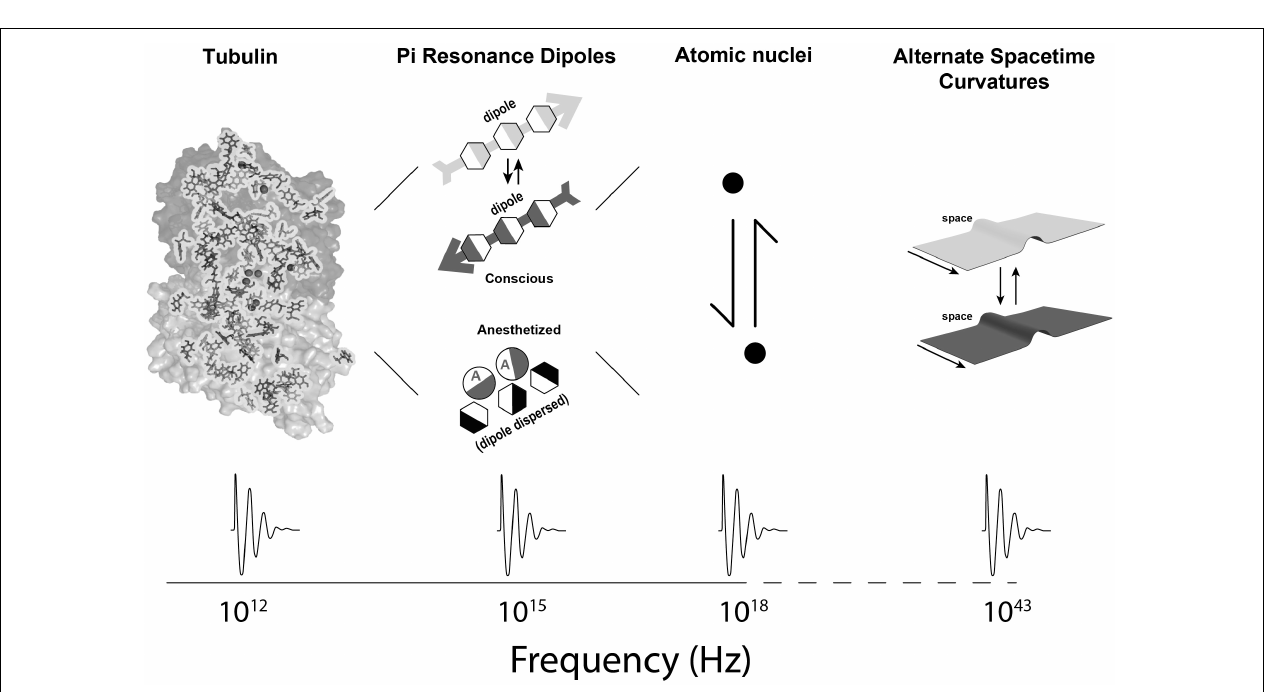
FIGURE 2 | Second part of a spatiotemporal hierarchy in which Orch OR-mediated consciousness can occur: From left to right, a single tubulin protein showing internal pi resonance amino acids, pi resonance dipoles with effect of anesthetic gases dispersing dipoles, atomic nuclei, and (much smaller) curvatures in fundamental spacetime geometry. At bottom, dynamical patterns of activity are shown at different spatiotemporal levels (hierarchical frequencies taken from Craddock et al., 2012a; Sahu et al., 2013a,b, 2014; Saxena et al., 2020).